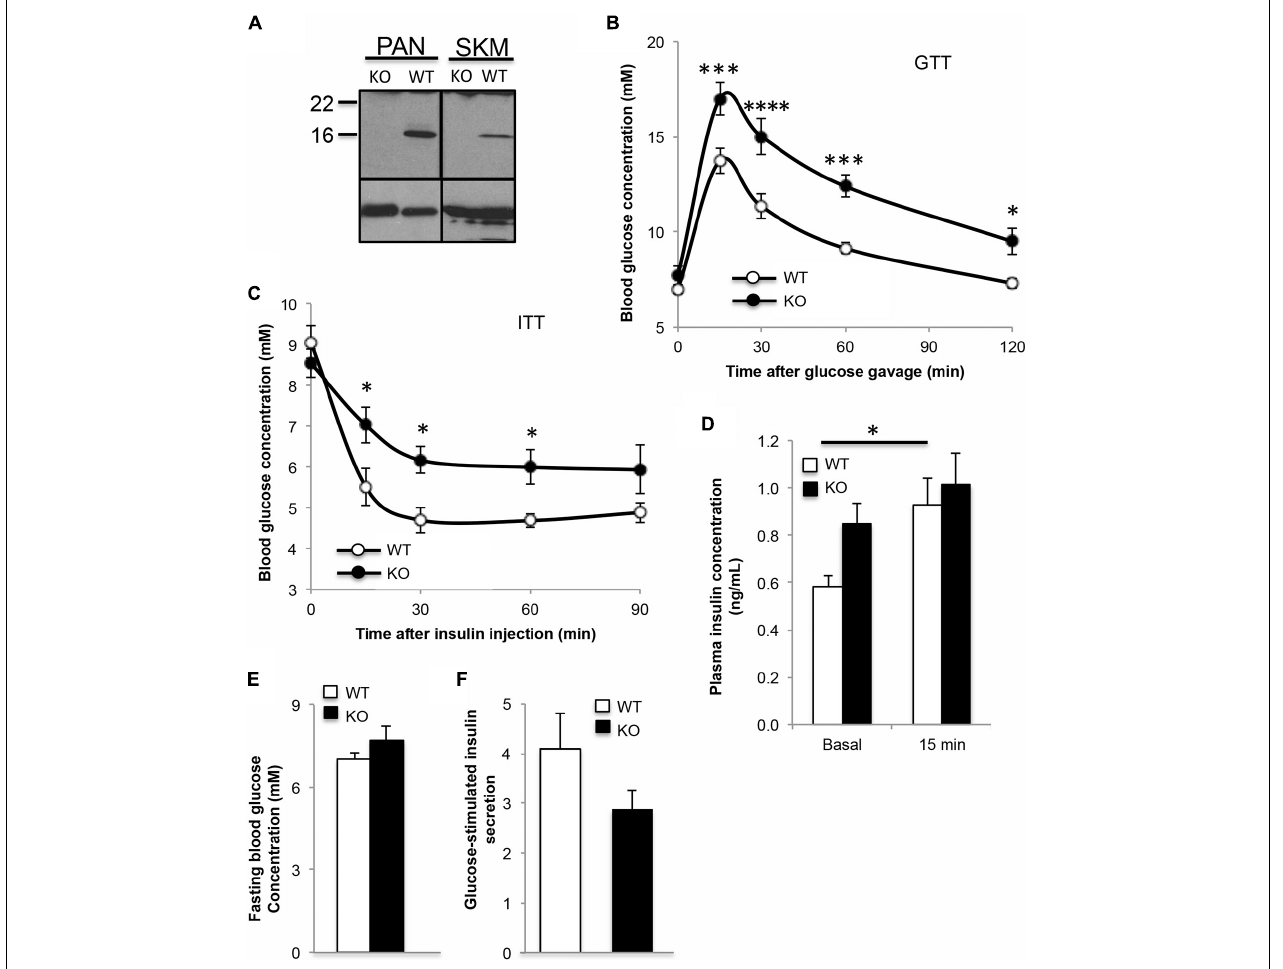
FIGURE 2 | Absence of α -syn leads to glucose intolerance and insulin resistance in mice. (A) Western blot analysis showing absence of α -syn in pancreas and skeletal muscle (skm), (B) oral glucose tolerance test ( GTT, 1.5g glucose/kg body weight ), (C) insulin tolerance test ( ITT, 0.75IU insulin/kg body weight ), (D) plasma insulin during GTT (0 and 15 min after glucose gavage), (E) fasting blood glucose and (F) glucose-stimulated insulin secretion expressed as fold over basal from isolated islets in 3 month old male wild type (WT, white bars ) and α -syn knockout (KO, black bars ) mice on chow diet [ (B–E) : n = 8–9, (F) : n = 4, * p < 0.05, *** p < 0.001, **** p <